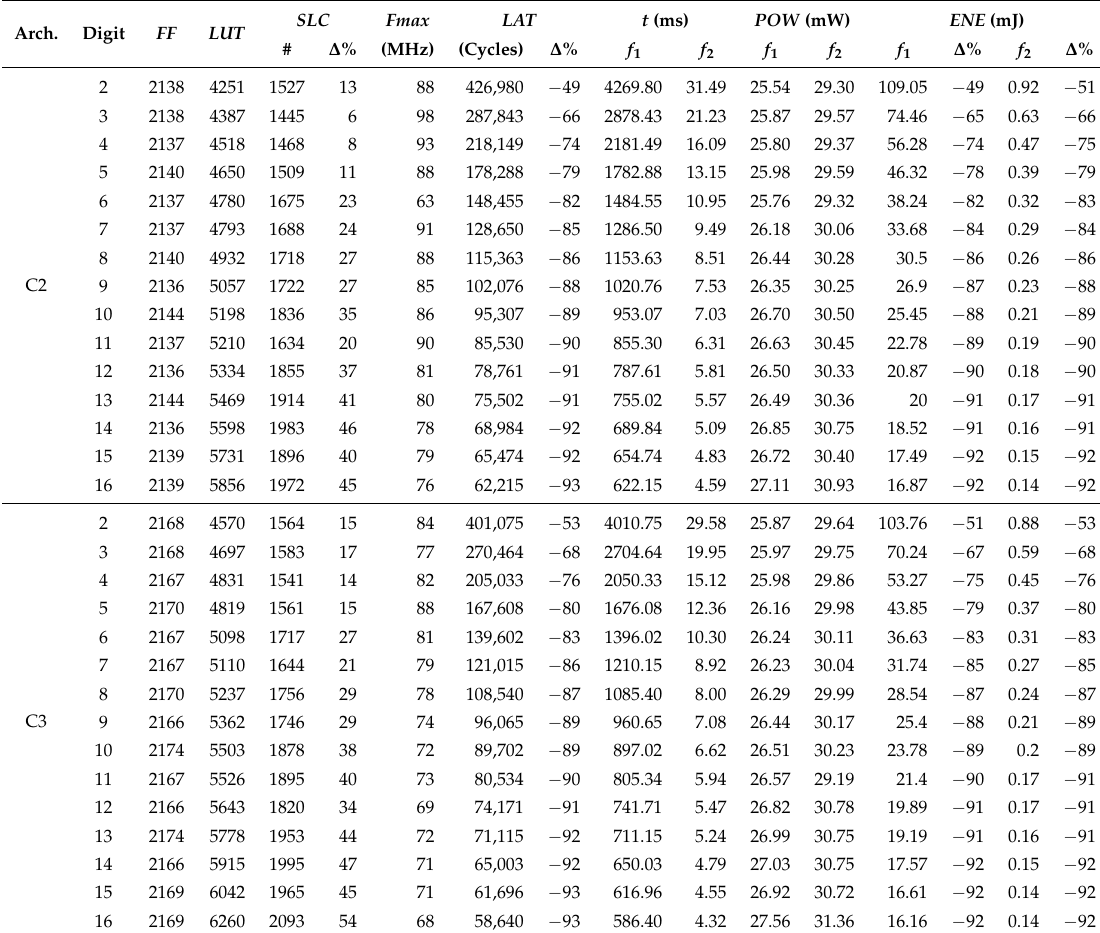
Table 5. Implementation results for C2 and C3 at frequencies of f 1 = 100 KHz and f 2 = 13.56 MHz, and variable multiplier digit size in the xc6slx16 FPGA. The ∆ % for C2 and C3 were computed in relation to C0 and C1,